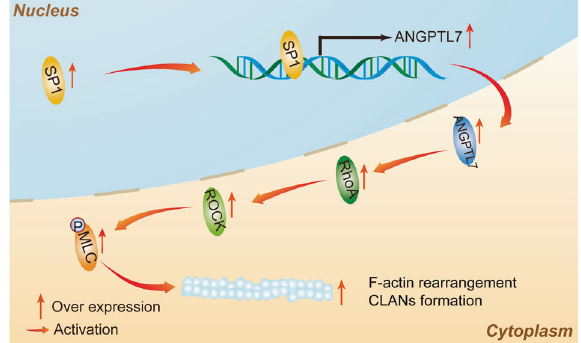
Fig. 7 Proposed molecular mechanisms of ANGPTL7 in CLAN formation in TM cells. ANGPTL7 expression is induced by SP1 initiation and activates the RhoA/ROCK signaling pathway to promote CLAN formation in TM cells.